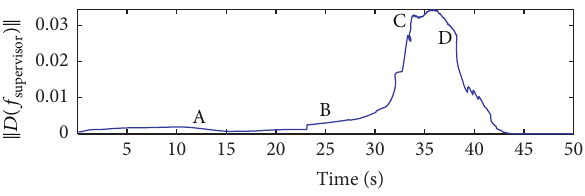
)‖ along the single mission supervisor